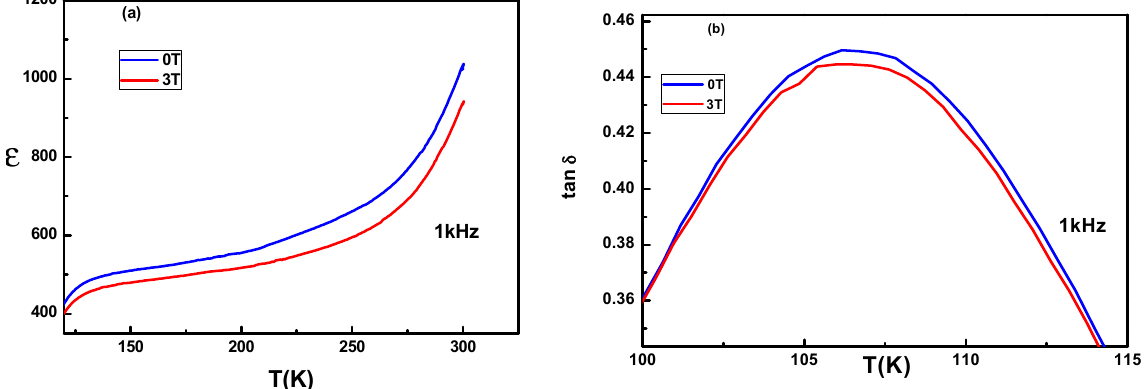
Figure 10. ( a ) and ( b ) The zoom part of the dielectric constant and the loss tangent at a frequency of 1kHz, for 0T and 3T, respectively.